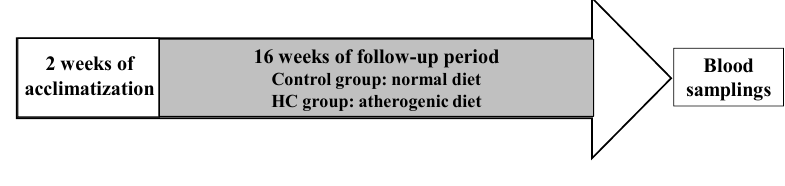
Figure 6. The timeline of the